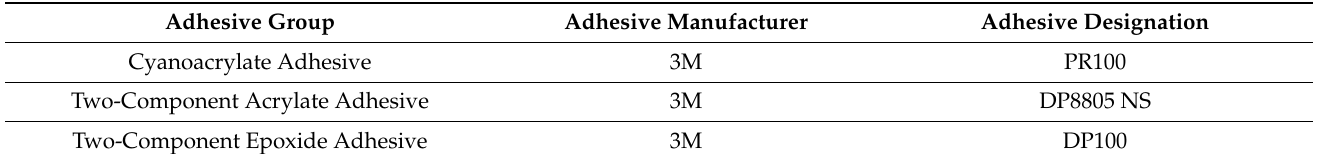
Table 2. List and designation of adhesives used.